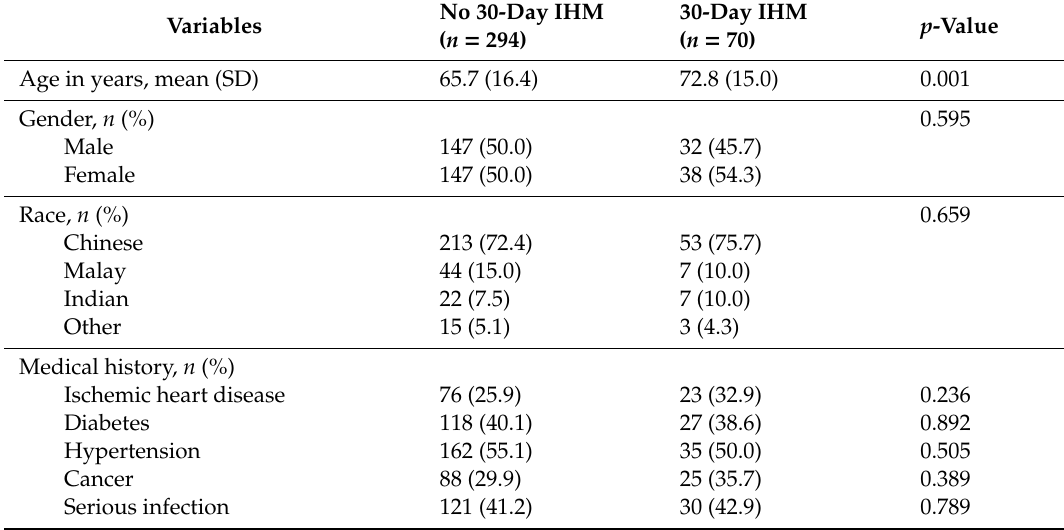
Table 1. Baseline characteristics and clinical parameters.